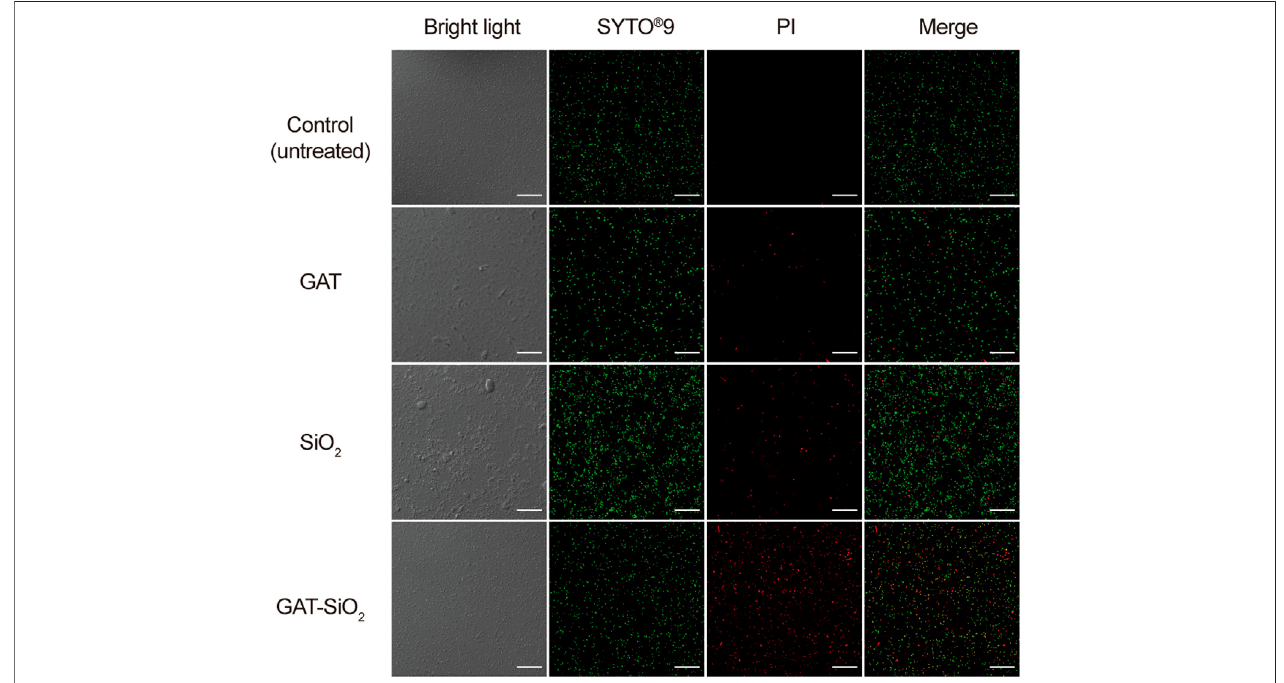
FIGURE 4 | The fl uorescent images are captured under CLSM after dying with DCFH-DA (green indicator). Scale bar represents 30 μ m.